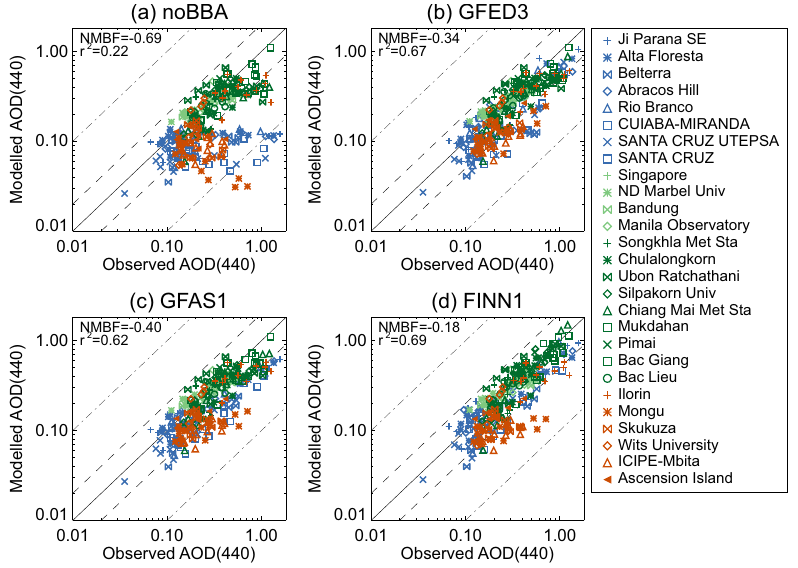
Figure 5. Simulated vs. observed multi-annual monthly mean AOD at 440nm at each AERONET station. The model is shown (a) without biomass burning emissions, and with (b) GFED3, (c) GFAS1 and (d) FINN1 emissions. As for Fig. 2, the multi-annual monthly mean AODs were calculated using all years of daily mean data available between January 2003 and December 2011 to obtain an average seasonal cycle at each station. AERONET stations located in South America are shown in blue, stations in Southeast Asia are shown in green (stations in equatorial Asia and Indochina in light and dark green, respectively), and stations in Africa are shown in orange. The normalised mean bias factor (NMBF) and Pearson’s correlation ( r 2 ) between modelled and observed PM 2 . 5 concentrations are shown in the top left